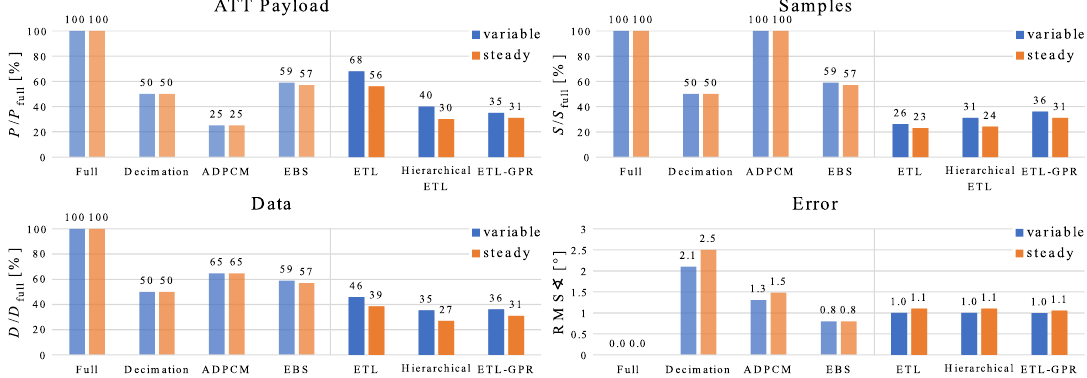
Figure 10. Performance comparison of seven methods. Data from feet-mounted sensors during 4 min of variable gait and normal walking is considered, respectively. The charts show the number P of transmitted data bits, i.e., the size of the ATT Payload, the number S of sampling instants with data transmission, and the total number D of transmitted bits including the Bluetooth 5 overhead with respect to full communication with the values P full , S full , and D full . In addition, the RMS-value of the angle difference between the measured and the estimated body segment orientation is displayed.